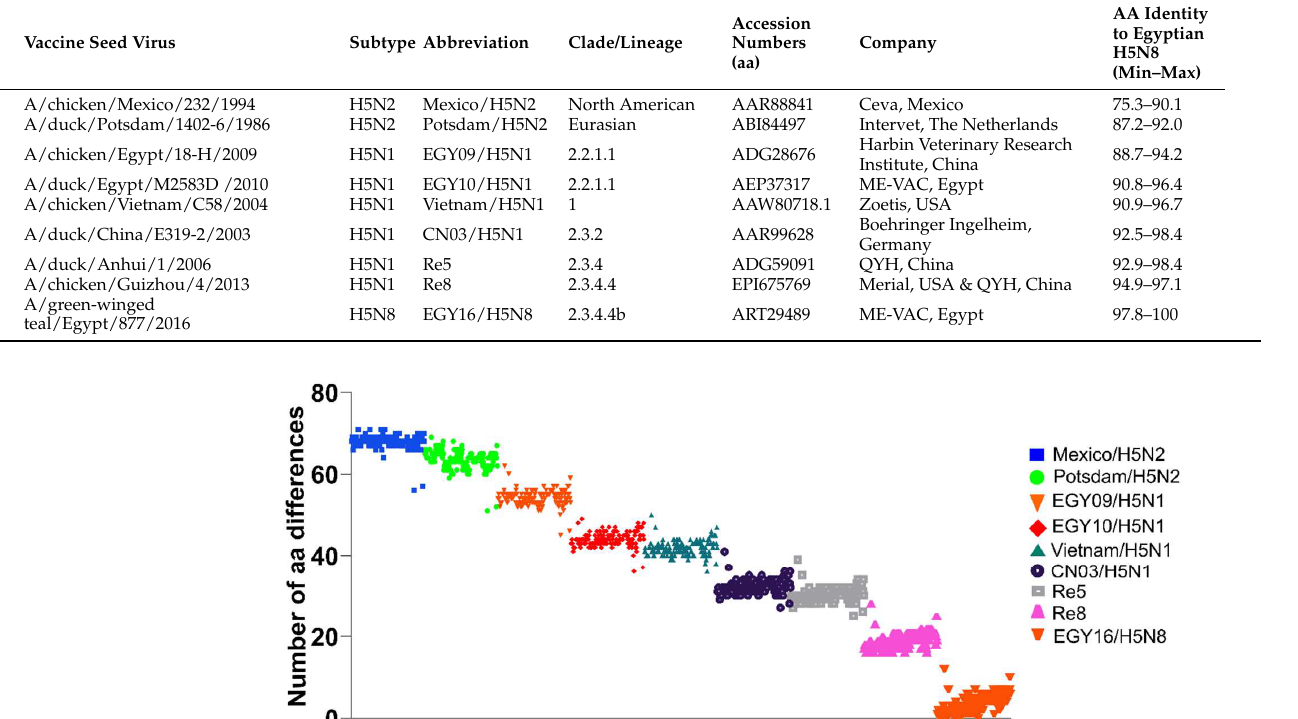
Table 2. Genetic identity of Egyptian H5N8 viruses to commercially available H5 vaccines currently used in poultry in Egypt.